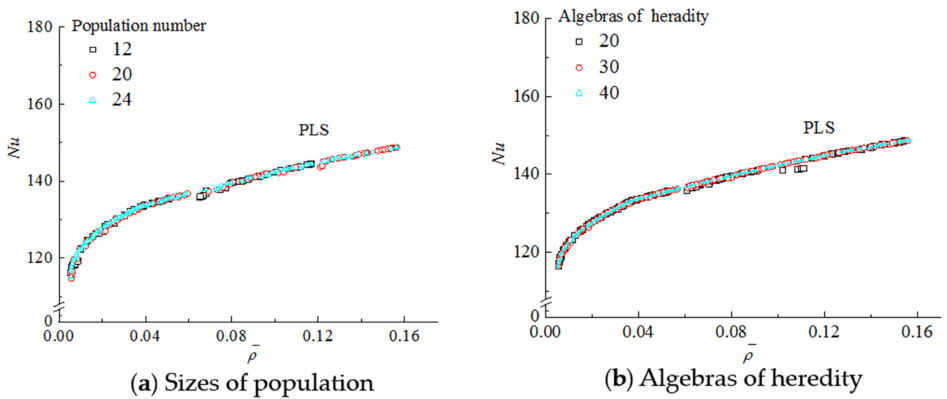
Figure 6. Influence of main parameters of genetic algorithm on the stability of